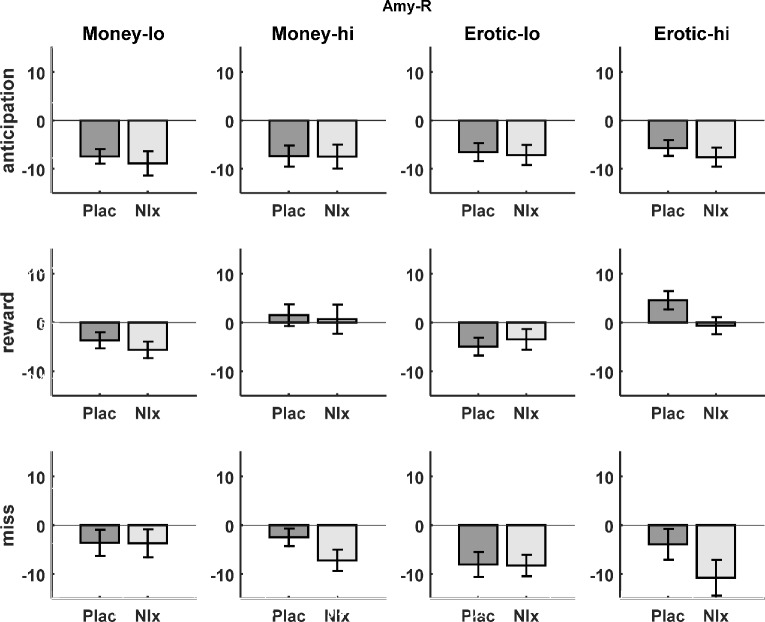
Right amygdala fMRI responses (arbitrary units) for all stimuli (money/erotic, high/low) and time-points (anticipation, outcome: reward, outcome: miss) under placebo (Plac) and naloxone (Nlx).Error bars represent standard error of the mean.